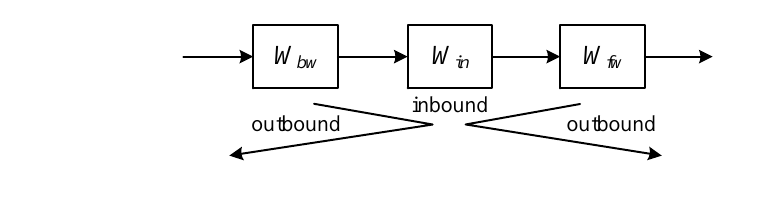
Figure 2: The Rebound-Attack Technique